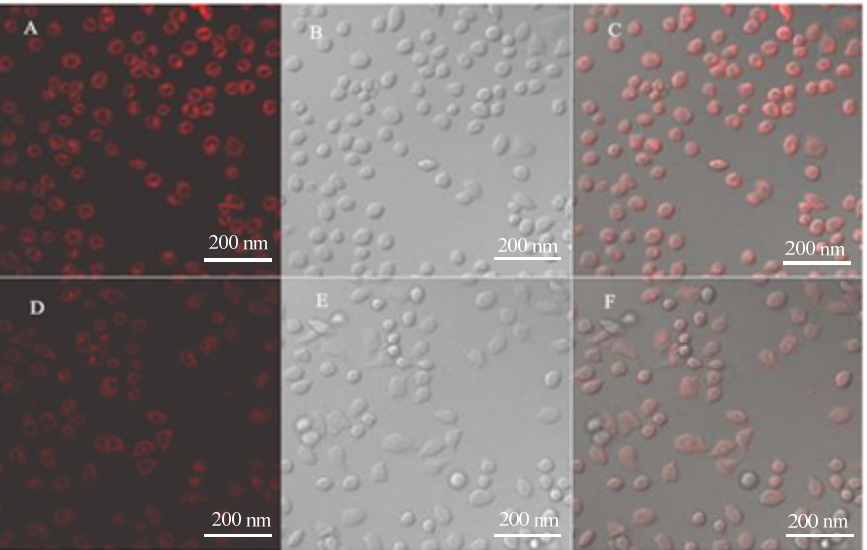
Figure 6. Confocal microscopic images of A549 cells: ( A ) is the A549 cells incubated in culture medium containing 2-ACP; ( D ) is the A549 cells incubated in the medium containing 2-ACP and with an pre-incubation in Fe 3+ -containing medium; ( B , E ) are the bright fields of ( A , D ), respectively; ( C ) and ( F ) are the overlays ( A , B ) and ( D , E ), respectively. The A549 cells incubated with 1.0 mmol/L 2-ACP and the same cells under a laser scanning confocal microscope.